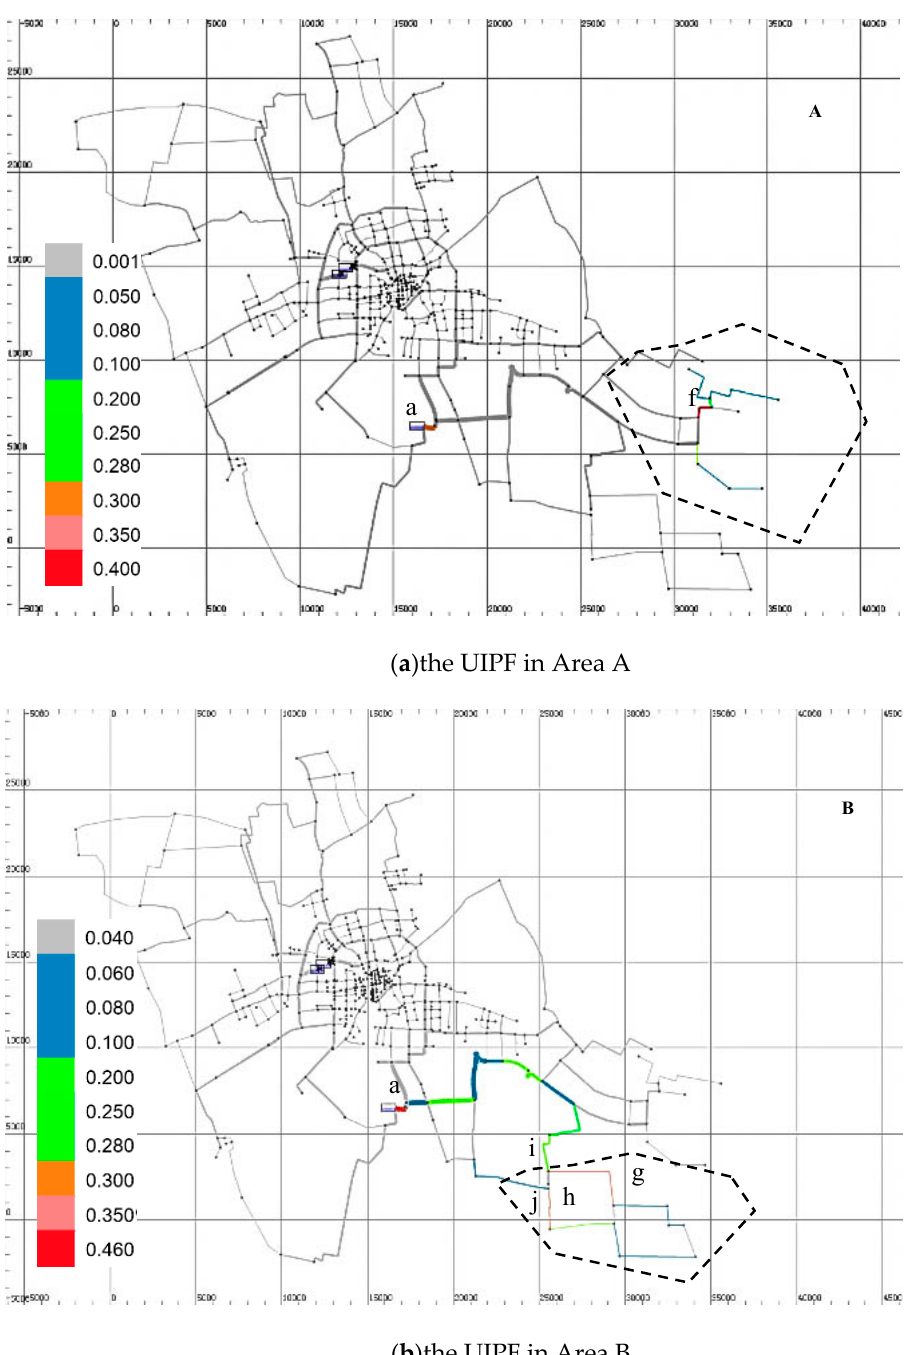
Figure 6. Analysis of the UIPF in local area of J city.